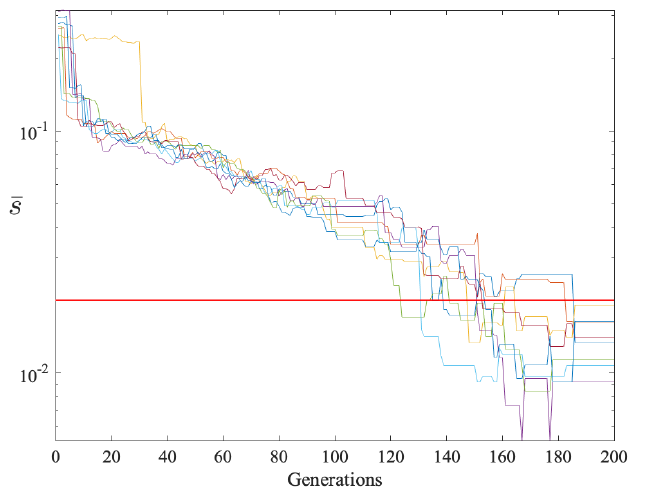
Figure 5. Row standard deviations versus generations for n = 10 players. There are 8 colored graphs, each one corresponding to a row in the demand matrix. All row deviations decreased to less than 0.02. The red line is at ¯ s =